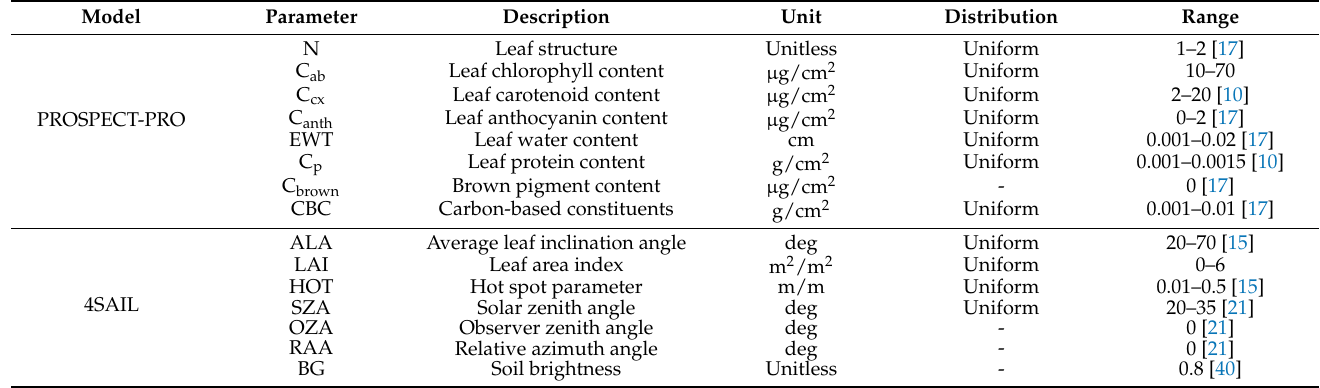
Table 4. Symbols, units, and parameter ranges of the input parameters of the PROSAIL